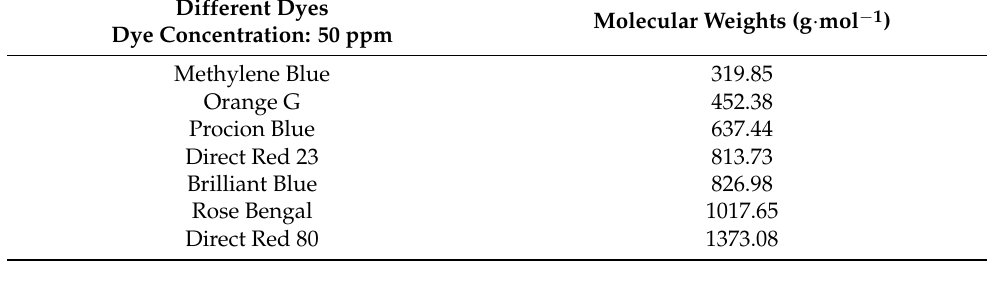
Table 3. Molecular weights of the dye.